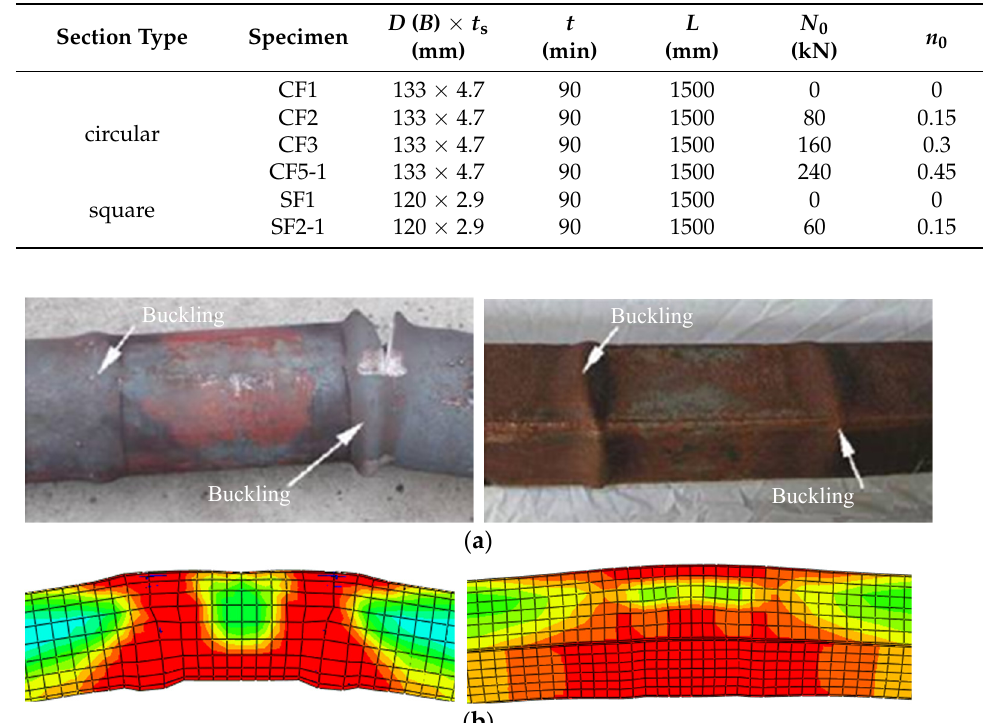
Table 1. List of test specimen parameters for hysteretic behavior of CFST.